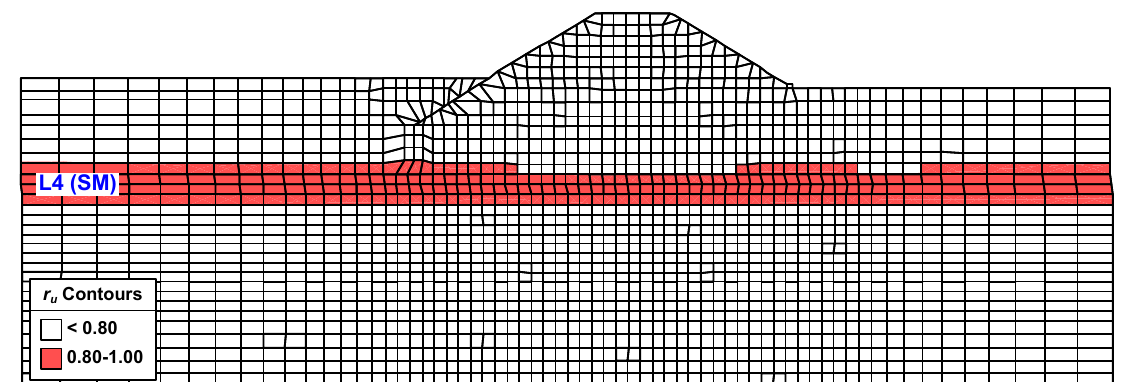
Figure 19. The distribution of EPWP ratio at earthquake time of 10 s.